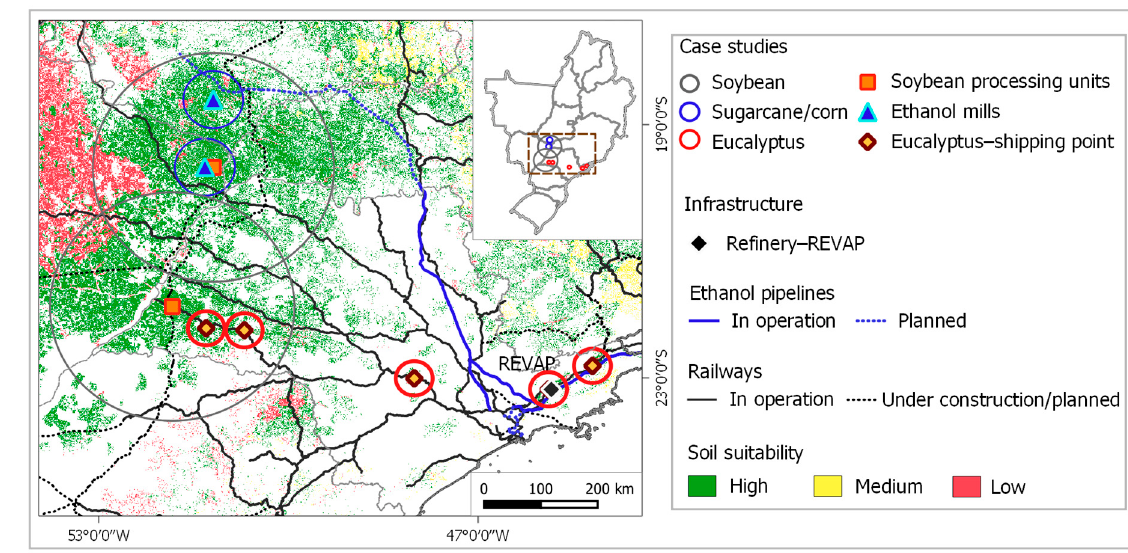
Figure 4. Considered sites of biomass production in the case studies (production within the circles of influence); the existing railways and the existing and planned ethanol branches of a pipeline are